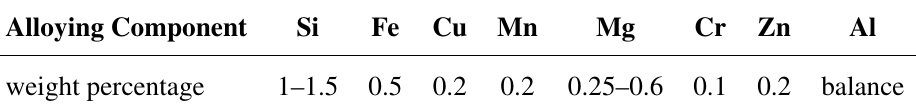
Table 2. Chemical composition (mass %) of AA6016 according to DIN EN 573-3:2007 [36]. Alloying